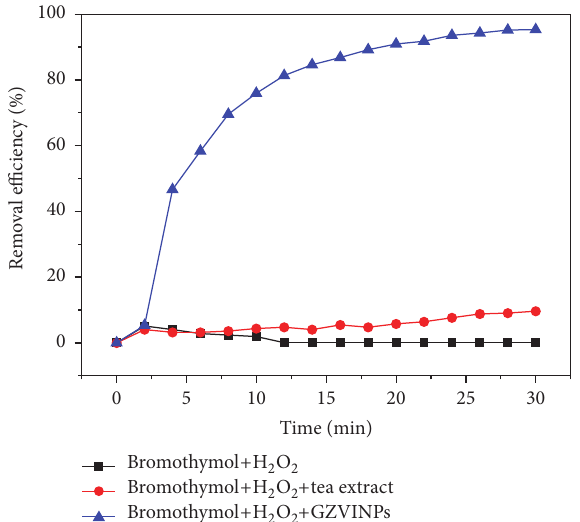
Figure 4: The degradation of bromothymol blue by tea extract and GZVINPs and in the absence of catalyst.